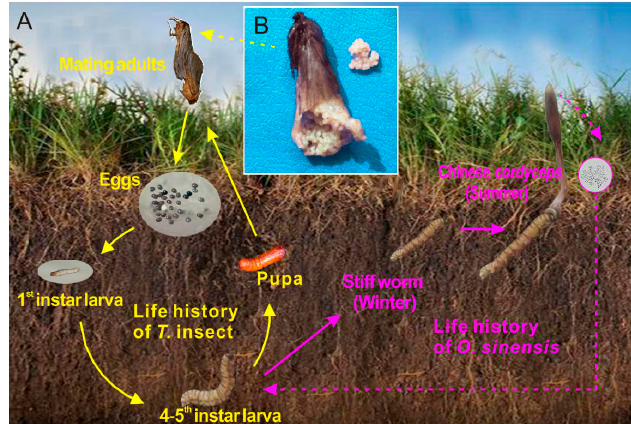
Figure 1. The life cycle of Ophiocordyceps sinensis and Thitarodes host ( A ) [7], and the unfertilized eggs with attached ovarian tissue from the female Thitarodes moth ( B ).